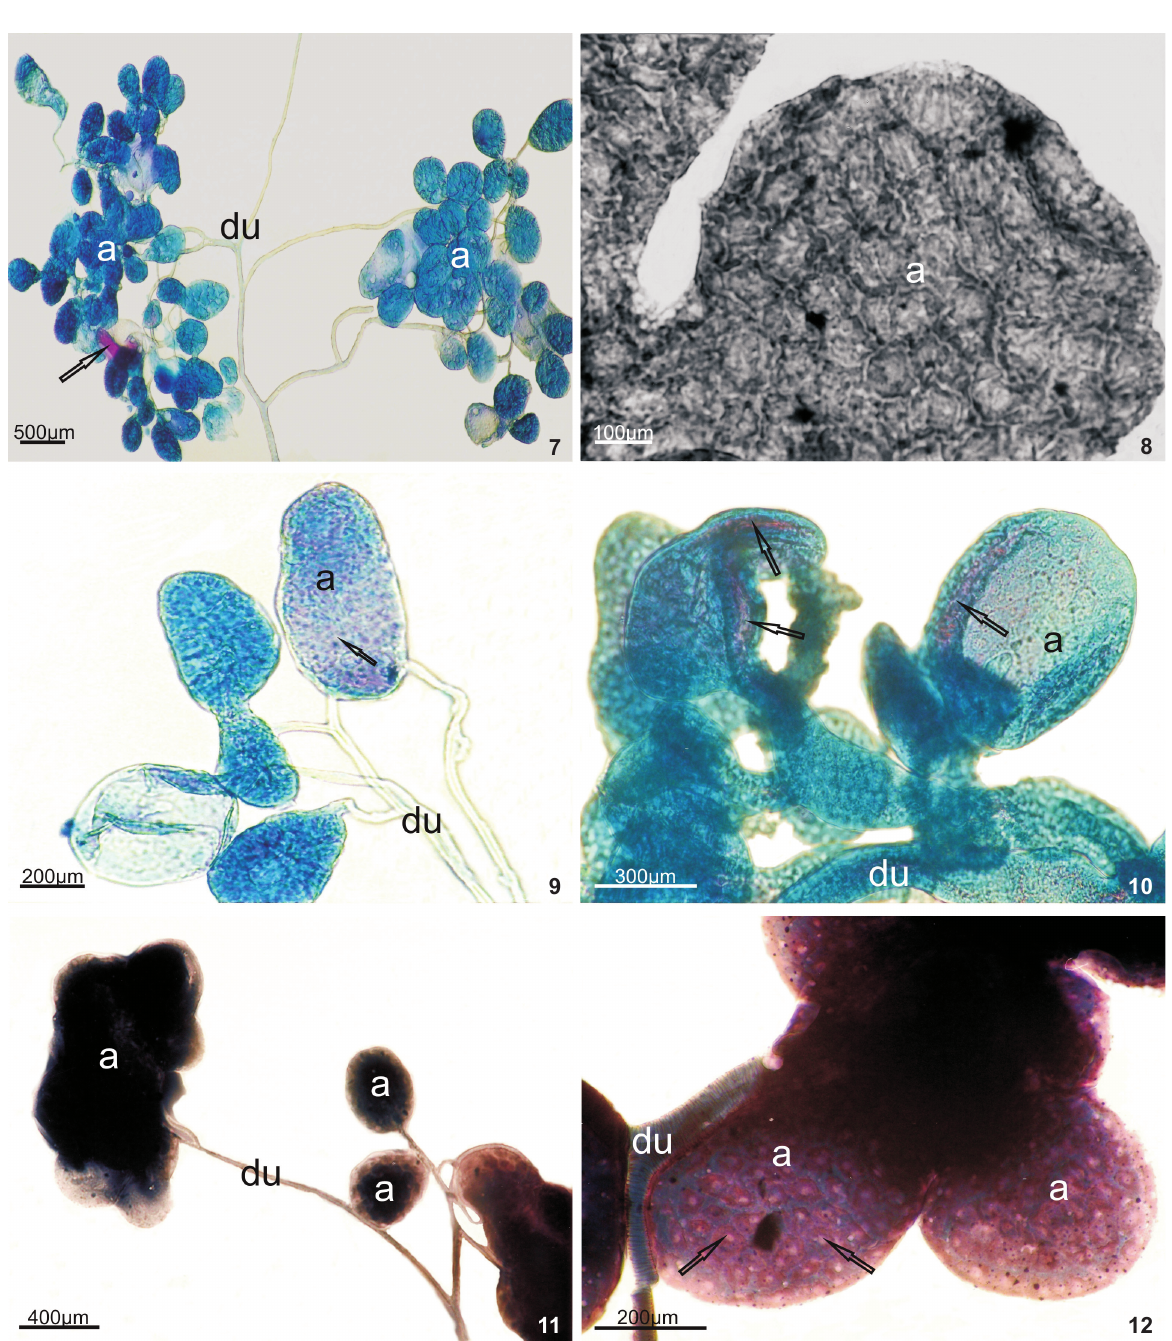
Figures 7-12. Total mounts of cephalic salivary glands (CSG): (7) CSG from newly emerged worker of Scaptotrigona postica showing secretion (arrow) stained pink with Nile’s blue. (8) Alveolus (a) from newly emerged worker of Apis mellifera stained with Sudan black, without secretion in the lumen, showing the cells limits and grayish cytoplasm. (9-10) Secretion (arrows) stained pink with Nile’s blue in nurse workers of S. postica and virgin queen of A. mellifera , respectively. (11) CSG from forager worker of S. postica with the alveoli (a) full of secretion stained black with the Sudan black. (12) Forager worker of A. mellifera showing dark-red secretion in the alveoli (a) satained by Sudan Black. Arrows indicate nucleus location. (a) Alveoli, (du)